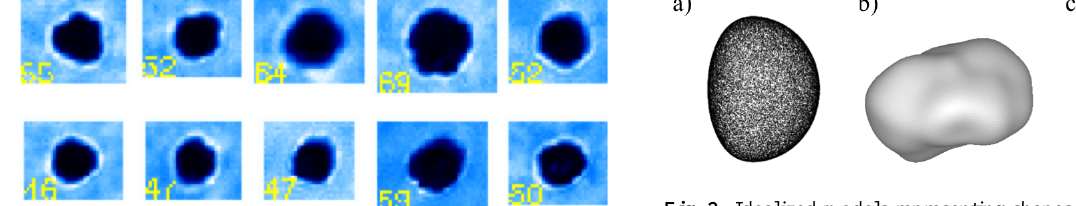
Fig. 2. Idealized models representing shapes of small ice crystals; (a) Chebyshev particle (Mugnai and Wiscombe, 1980); (b) Gaussian random sphere (Nousiainen and McFarquhar, 2004); and (c) droxtal (Yang et al., 2003).